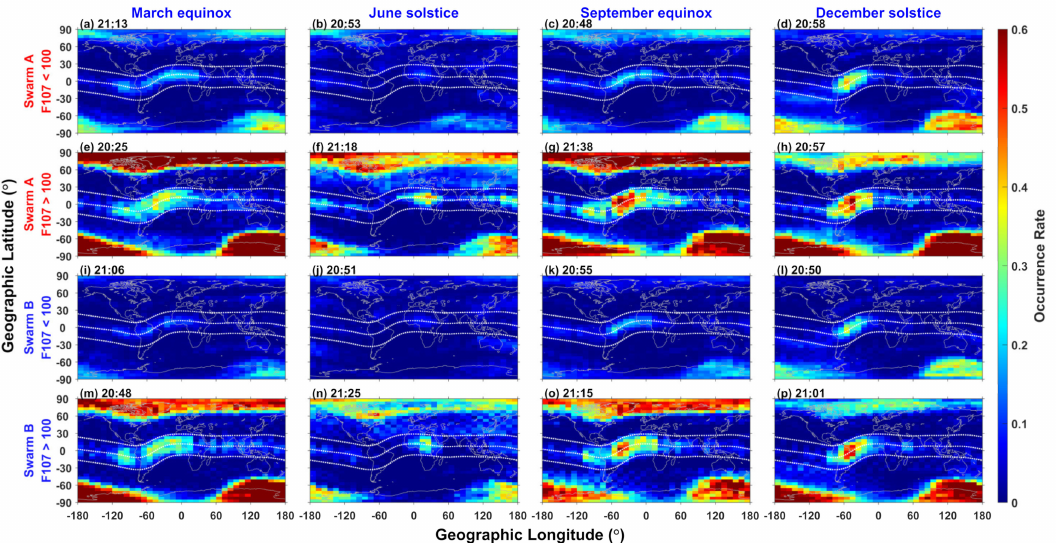
Figure 2. Global distribution of occurrence rate by RODI for different seasons, satellites, and F107 in geographic coordinates before midnight. The mean local time was marked in the subtitle. The pixels has a resolution of 10 ◦ in geographic longitude and 2.5 ◦ in geographic latitude. The contour lines of the geomagnetic latitudes at ± 20 ◦ (white line) are also plotted for reference. The color- bar ranges are set as the same at each column. The panels from top to bottom show results for Swarm A (F107 < 100, ( a – d )), Swarm A (F107 > 100, ( e – h )), Swarm B (F107 < 100, ( i – l )), and Swarm B (F107 > 100, ( m – p )), from left to right show results at March equinox, June solstice, September equinox, and December